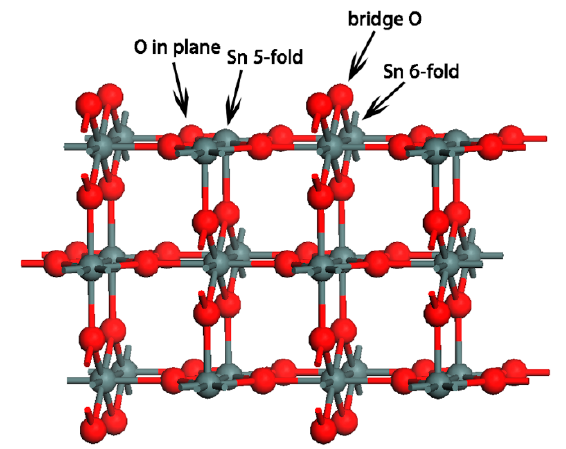
Figure 11. The optimized SnO 2 (110) surface.